Question: Condense the content of this figure into a single sentence.
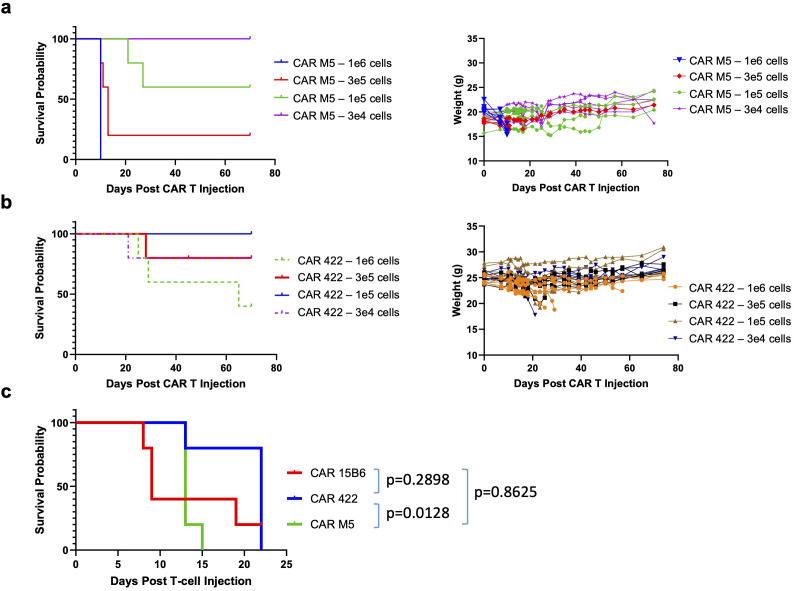
Answer: Evaluation of CAR T cell toxicity in huMSLN NSG mouse model. Non-tumor bearing huMSLN knock-in (KI) mice (n = 5 mice per group) were administered the indicated number of (a) CAR M5 or (b) CAR 422 T cells IV to assess off-tumor/on-target toxicity. Left-hand panels of (a) and (b) show probability of survival based on weight and health and right-hand panels of (a) and (b) show percent body weight change following T-cell injection as an indicator of toxicity and tolerability. (c) Non-tumor bearing huMSLN-KI mice (n=5 mice per group) were treated by injection of 1e6 CAR 422, 15B6, or M5 CAR T cells to evaluate relative toxicity. Statistical analysis used the Mantel-Cox log-rank test.